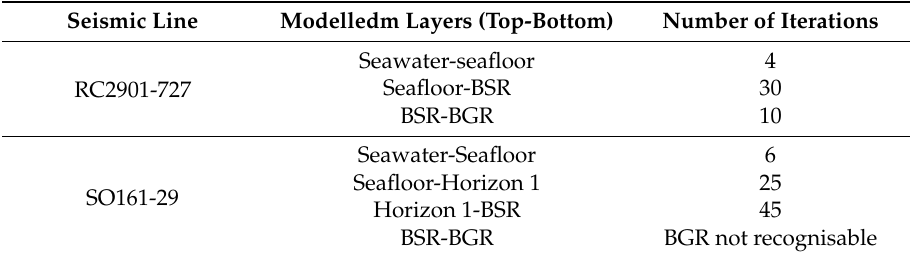
Table 1. Details about the number of iterations necessary to obtain the final velocity model for each layer of the two analysed seismic